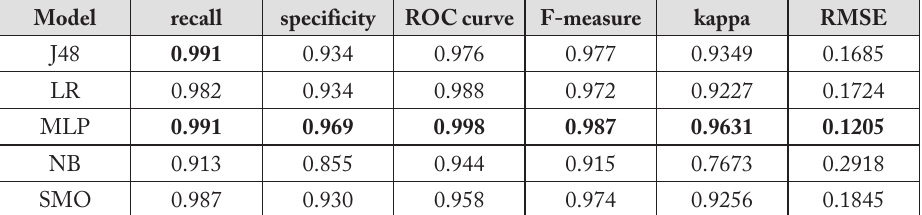
Table 5: Comparison of the models: Performance on the test dataset, using the six selected metrics Model